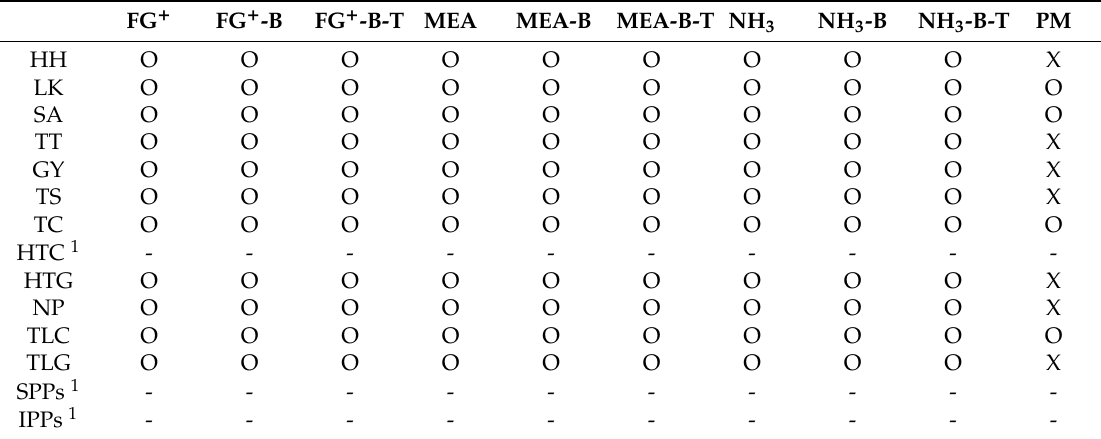
Table 4. Compatibility between thermal power plants and CC